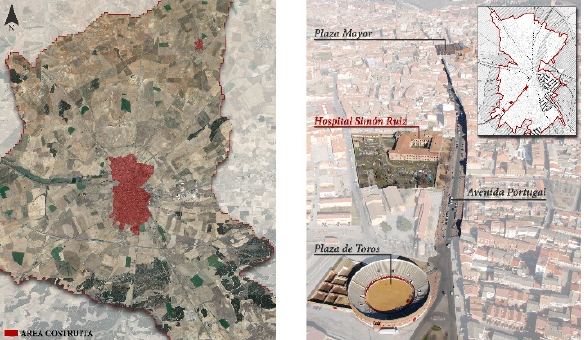
Figure 3: The Simón Ruiz Hospital in the urban context of Medina del Campo (Valladolid, Spain).